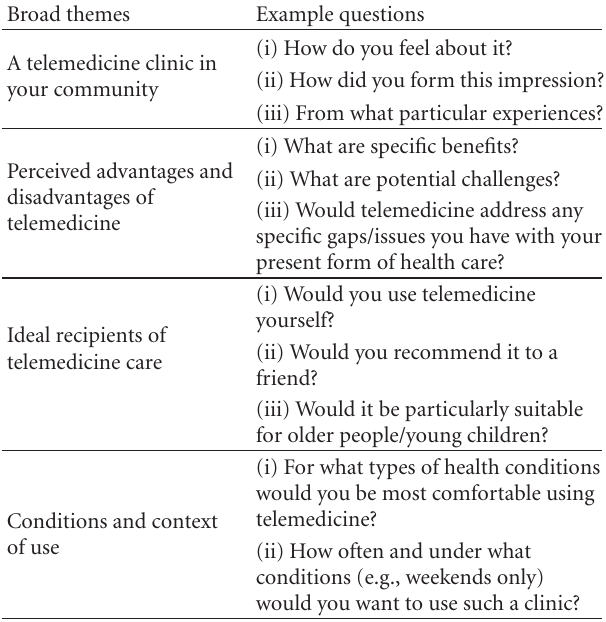
Table 2: Focus group script—interview themes and examples